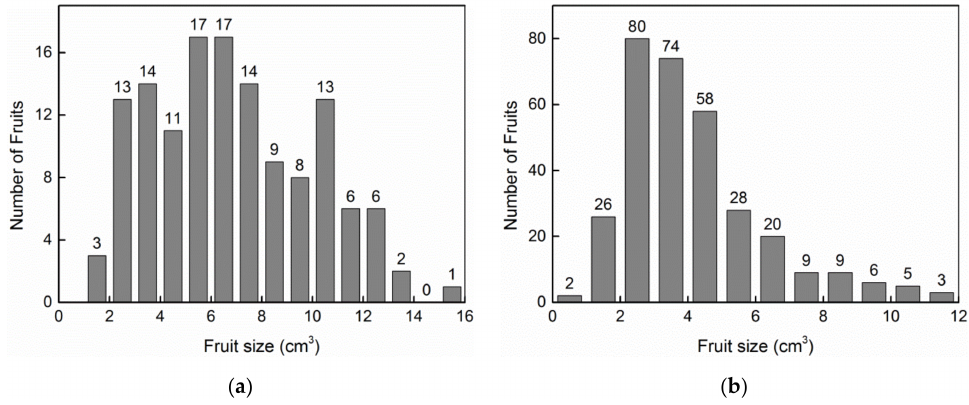
Figure 1. Frequency of the weevil-infested fruits: ( a ) C . oleifera ; ( b ) C . meiocarpa .